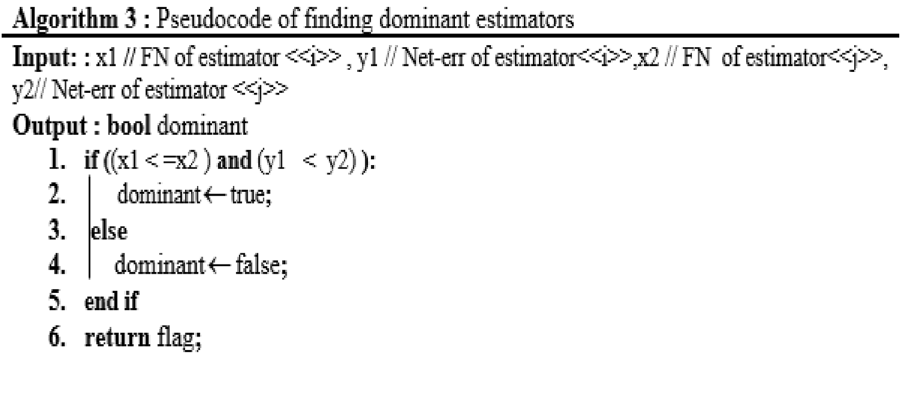
Figure 7. Algorithm 3: Pseudocode of finding dominant estimators.